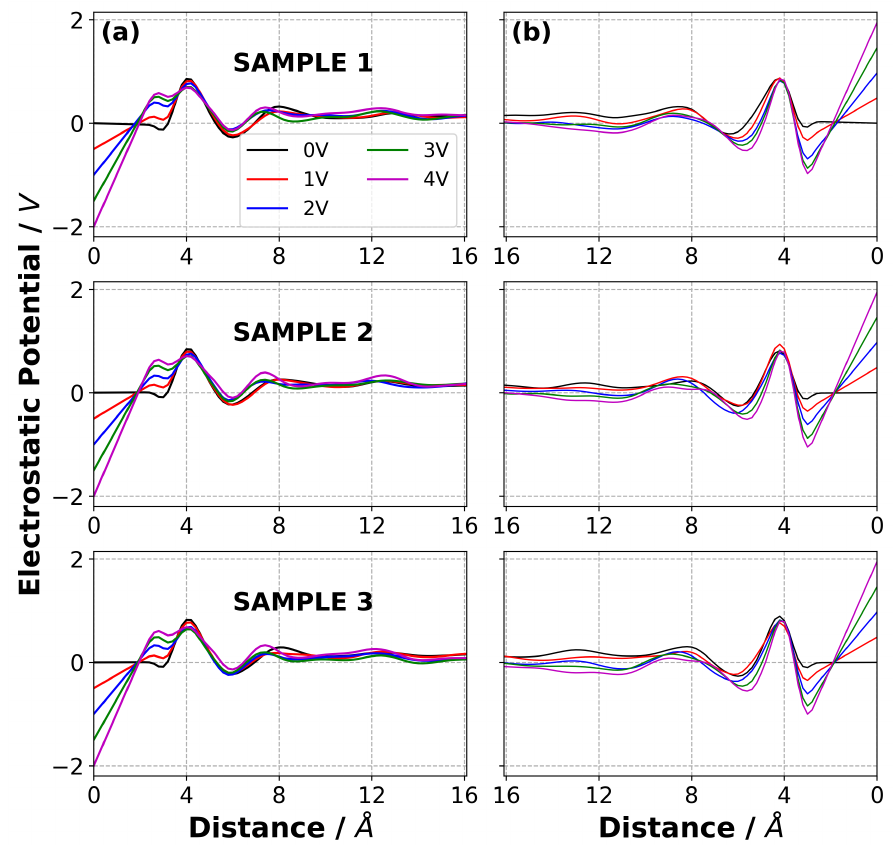
Figure 10. Electrostatic potential profile as a function of ∆Ψ for [C 2 mim][NTf 2 ] system on the ( a ) negative electrode and ( b ) positive electrode for each sample at 294 K. The distance of zero corresponds to the electrode surface. The three samples were simulated under identical conditions but with different initial configurations. They give an indication of the robustness of the